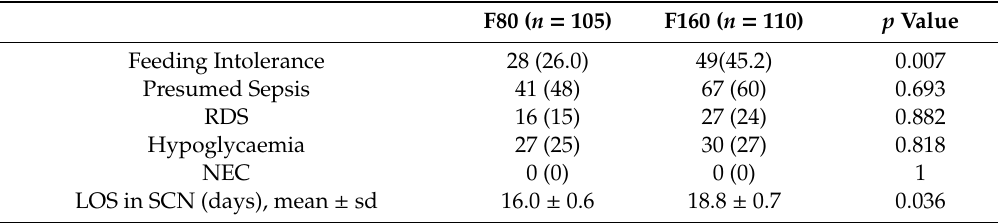
Table 5. Adverse clinical